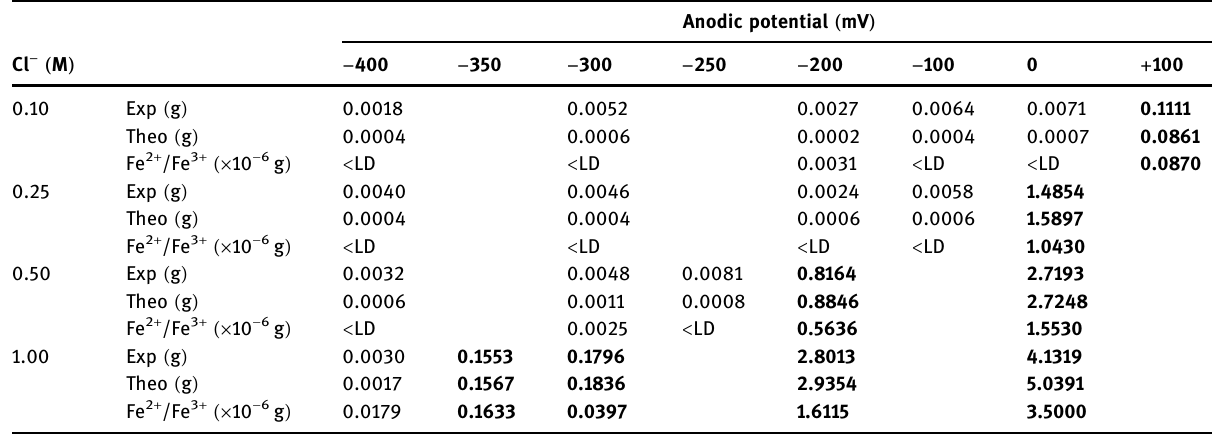
Bold digits refer to steel wire having pitting corrosions and < LD refer to below the detected